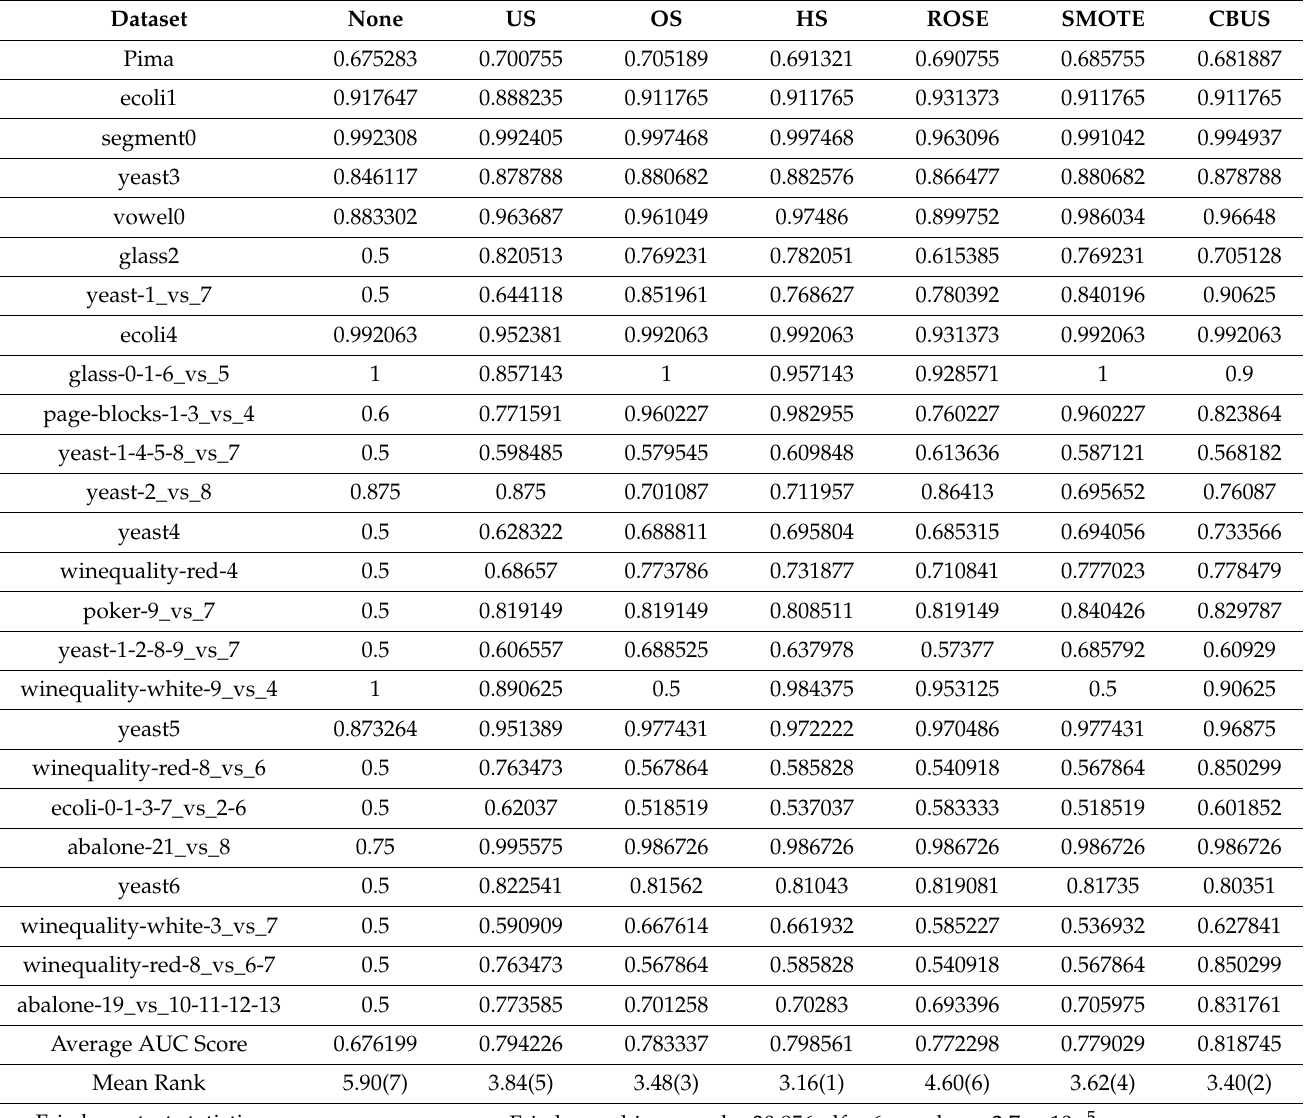
Table 7. Performance of DBT for